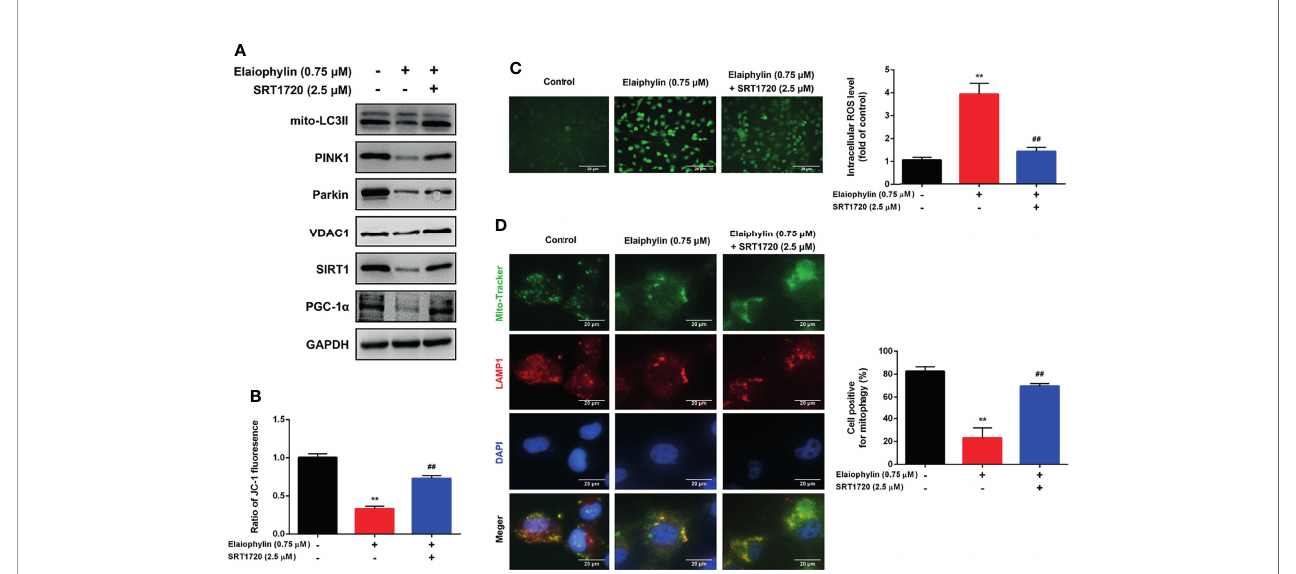
FIGURE 4 | Elaiophylin inhibits mitophagy in C918 cells by regulating SIRT1. After pre-treatment with SRT1720 (a SIRT1 speci fi c activator) for 24 h, C918 cells were incubated with Elaiophylin for another 24 h. (A) Western blotting was performed to analyze the proteins related to mitophagy. GAPDH and VDAC1 were used as loading controls for cytoplasm and mitochondria, respectively. (B) The membrane potential of C918 cells pre-treatment with or without SRT1720 followed by the incubation with or without Elaiophylin was evaluated by JC-1 fl uorescent probe. (C) Intracellular ROS level was determined by DCFH-DA fl uorescent probe. The representative images of fl uorescent probe were shown on the left and the quantitative analysis of ROS level was shown on the right. (D) Colocalization of mitochondria and lysosomes. Mitochondria were stained with MitoTracker Green (200 nM), and lysosomes were stained with LAMP1 (red fl uorescence). The representative images of fl uorescent labeling were shown on the left and the quantitative analysis of cellular mitophagy was shown on the right (Image J was used for quantitative analysis of fl uorescence co-localization, and fi ve different visual fi elds of each group were selected for measurement). Data was expressed as mean ± SD of three experiments. ** p <0.01 vs. control, ## p <0.01 vs. Elaiophylin